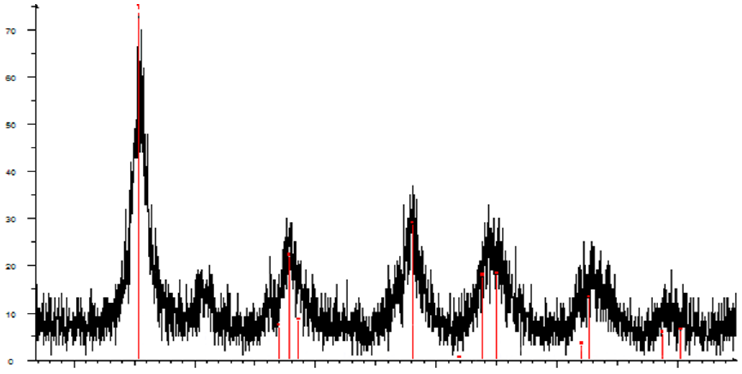
Figure 2. X-ray diffraction analysis of titanium dioxide TiO 2 powder obtained by low-temperature sol-gel.